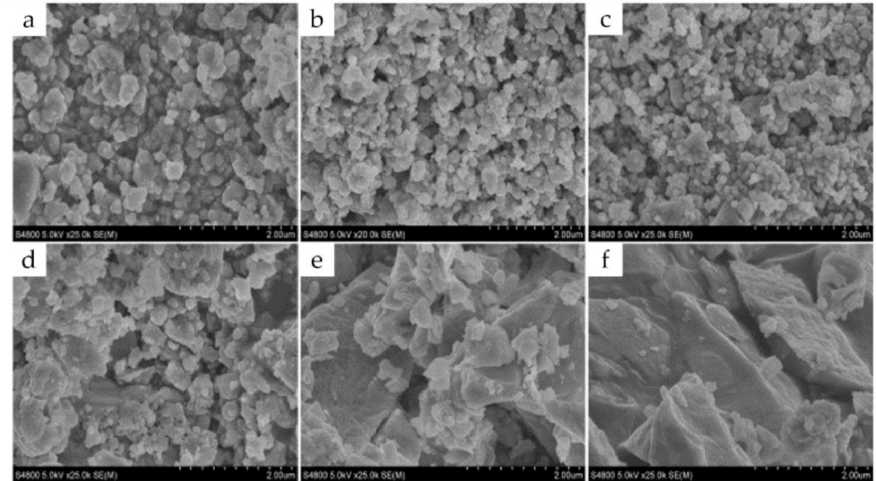
Figure 5. SEM images of the calcined samples: ( a ) K 0 CsCuNH 4 PA; ( b ) K 0.3 CsCuNH 4 PA; ( c ) K 0.6 CsCuNH 4 PA; ( d ) K 0.9 CsCuNH 4 PA; ( e ) K 1.2 CsCuNH 4 PA; ( f ) K 1.5 CsCuNH 4